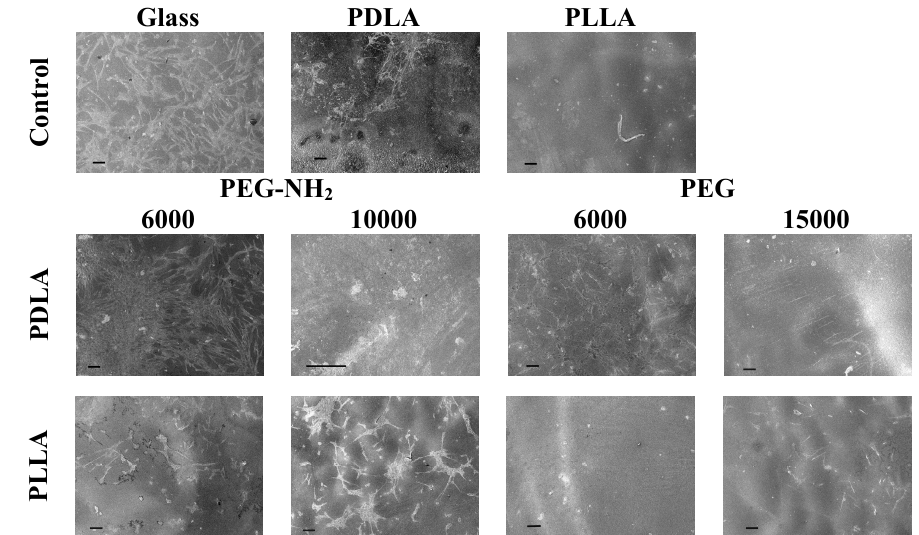
Figure 6. SEM images of the MSC cells after one day of cultivation on the pure glass and on the pure films from PLA with different isomeric forms—PDLA and PLLA (control); the blend PLA/PEG or PLA/PEG-NH2 with different molecular weights of PEG (6000 or 15,000 g/mol) and PEG-NH2 (6000 or 10,000 g/mol). Scale bar 100 µm.